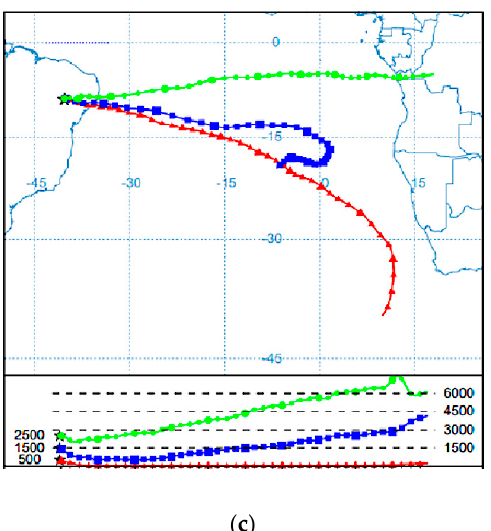
Figure 10. Case study CS-3 on 1 November 2007 at Petrolina/PE. ( a ) Total attenuated backscatter at 532 nm from CALIOP/CALIPSO. ( b ) Aerosol subtype from CALIOP/CALIPSO displaying the presence of (1) clean marine (in blue), (2) dust (in yellow), (3) polluted continental (in red), (4) clean continental (in green), (5) polluted dust (in brown) and (6) smoke (in black) aerosols ( c ) 10-day simulations of the backwards trajectories from